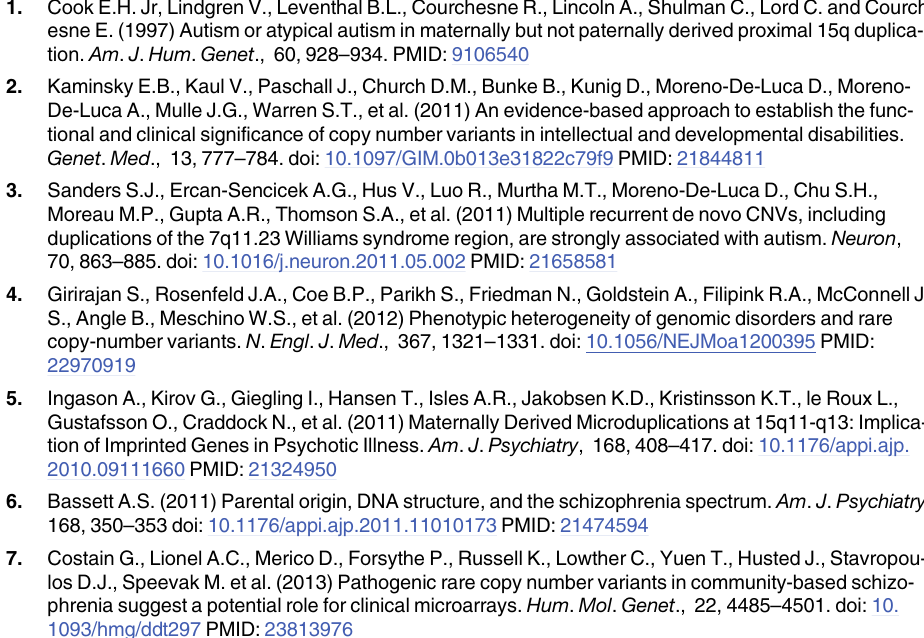
S2 Fig. Examples of B Allele Frequency and Log R Ratios (Illumina arrays) for 4 schizo- phrenia duplication carriers (top part of the figure) and 2 developmental delay triplication carriers for BP1-BP4 region (with duplicated BP4-BP5 region), demonstrating the unam- biguous pattern of traces that distinguish duplications from triplications in the region: triplications have 5 bands of B Allele Frequency traces, while duplications have 4 bands. S1 Table. Neuropsychiatric characteristics of subjects described in this study. Details of abbreviations can be found in the “ Coding Key ” tab. S2 Table. Medical characteristics of subjects described in this study. Details of abbreviations can be found in the “ Coding Key ” tab. S3 Table. Penetrance and population frequency estimates for the 15q11-q13 duplication, assuming lower population frequencies of SZ (0.5%) and DD/ASD/MCA (2%), and a resulting frequency of healthy controls of